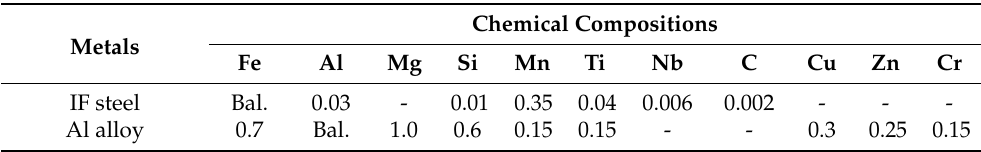
Table 1. Chemical compositions of IF steel and Al alloy (wt.%).